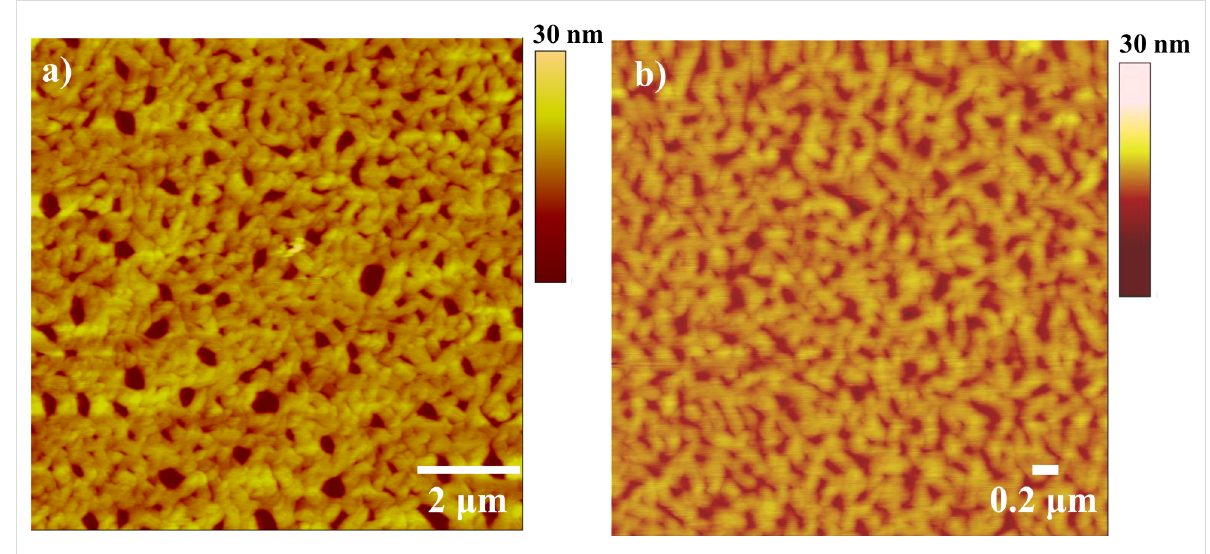
Figure 4: AFM height image of observed nanostructures of films drop cast from (a) 10 mg/mL and (b) 1 mg/mL chloroform solution of 2 .